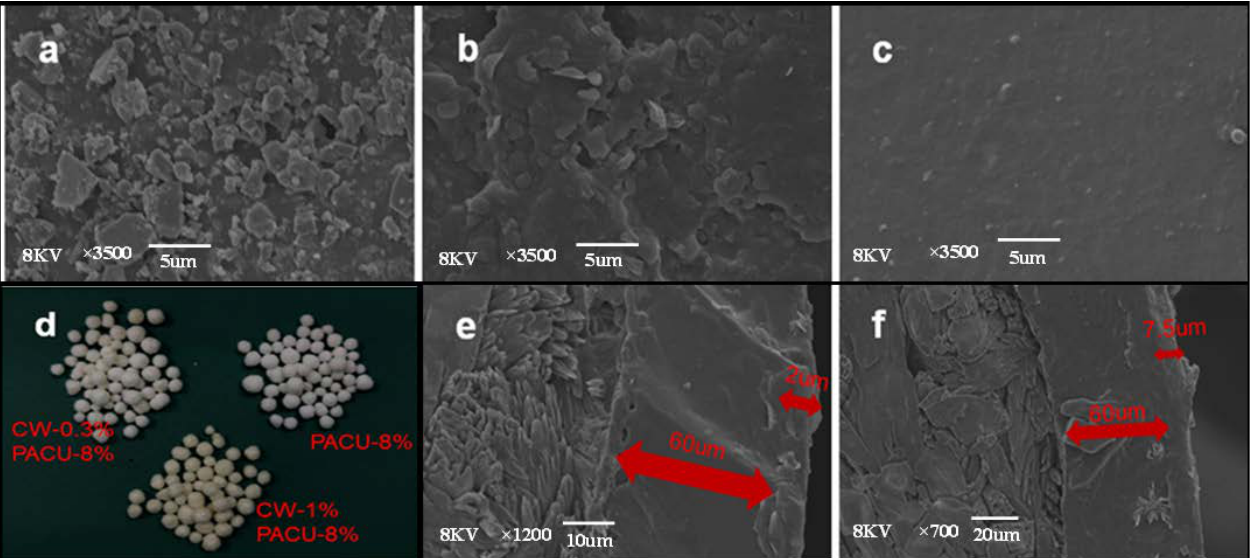
Figure 2. Scanning electron microscopy (SEM) images of the surface and section of coated urea. ( a ) Surface of PACU with 8% content of PWA. ( b ) Surface of CWPACU with 8% content of PWA and 0.3% content of Carnauba wax (CW). ( c ) Surface of CWPACU with 8% content of PWA and 1% content of CW. ( d ) appearance of coated urea using varied rate s of CW and PACU. ( e ) Section of CWPACU with 8% content of PWA and 0.3% content of CW. ( f ) Section of CWPACU with 8% content of PWA and 1% content of